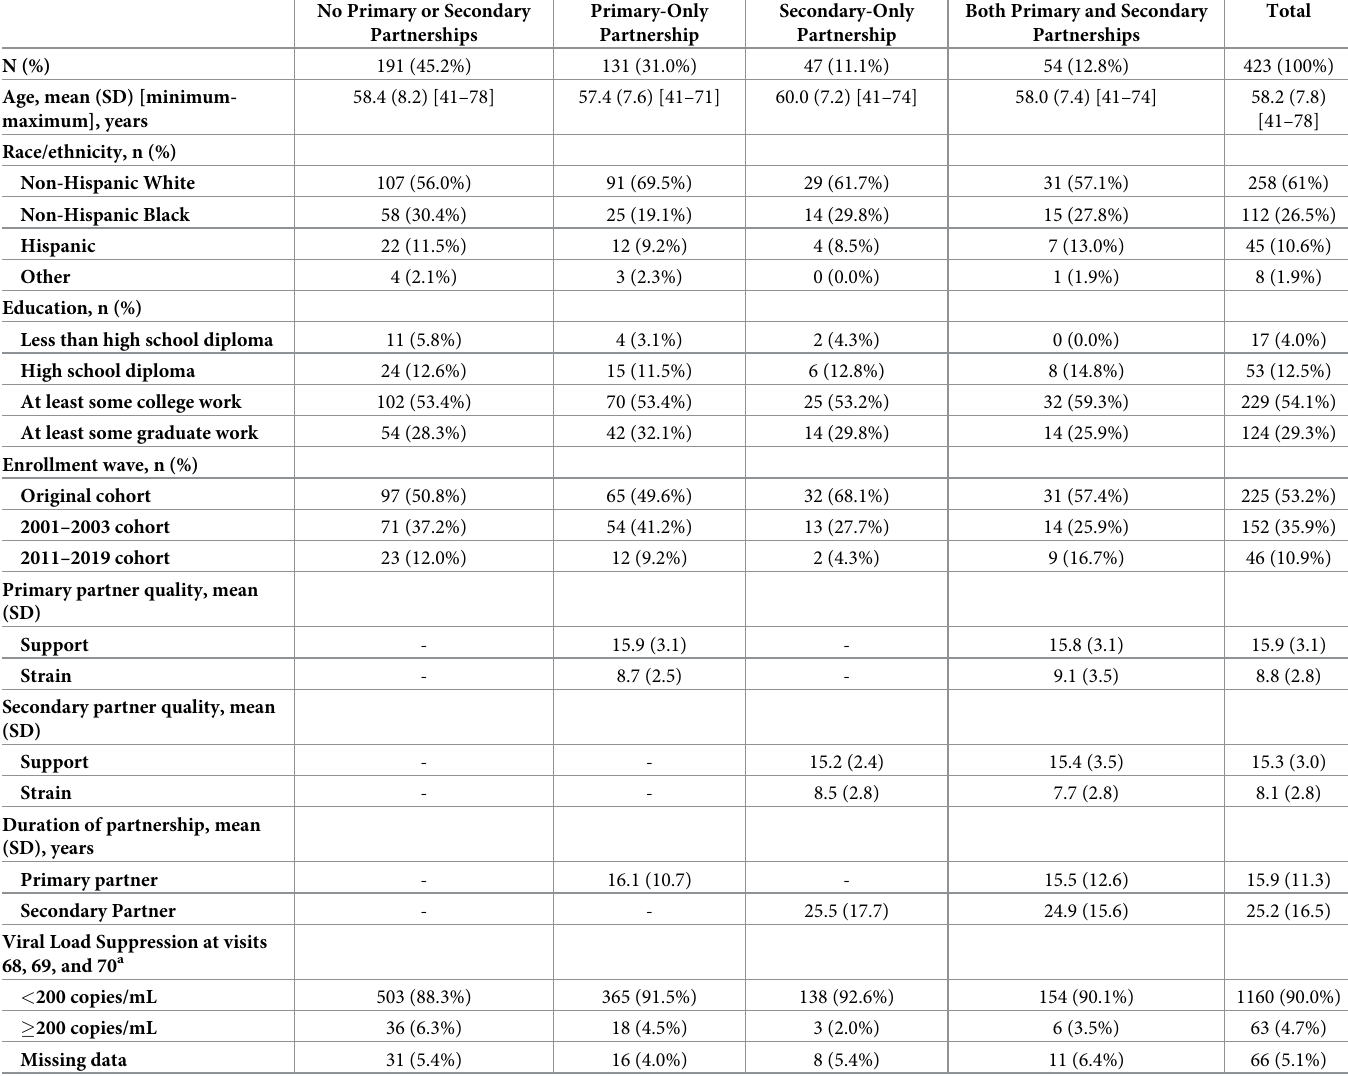
Table 1. Population characteristics by partnership